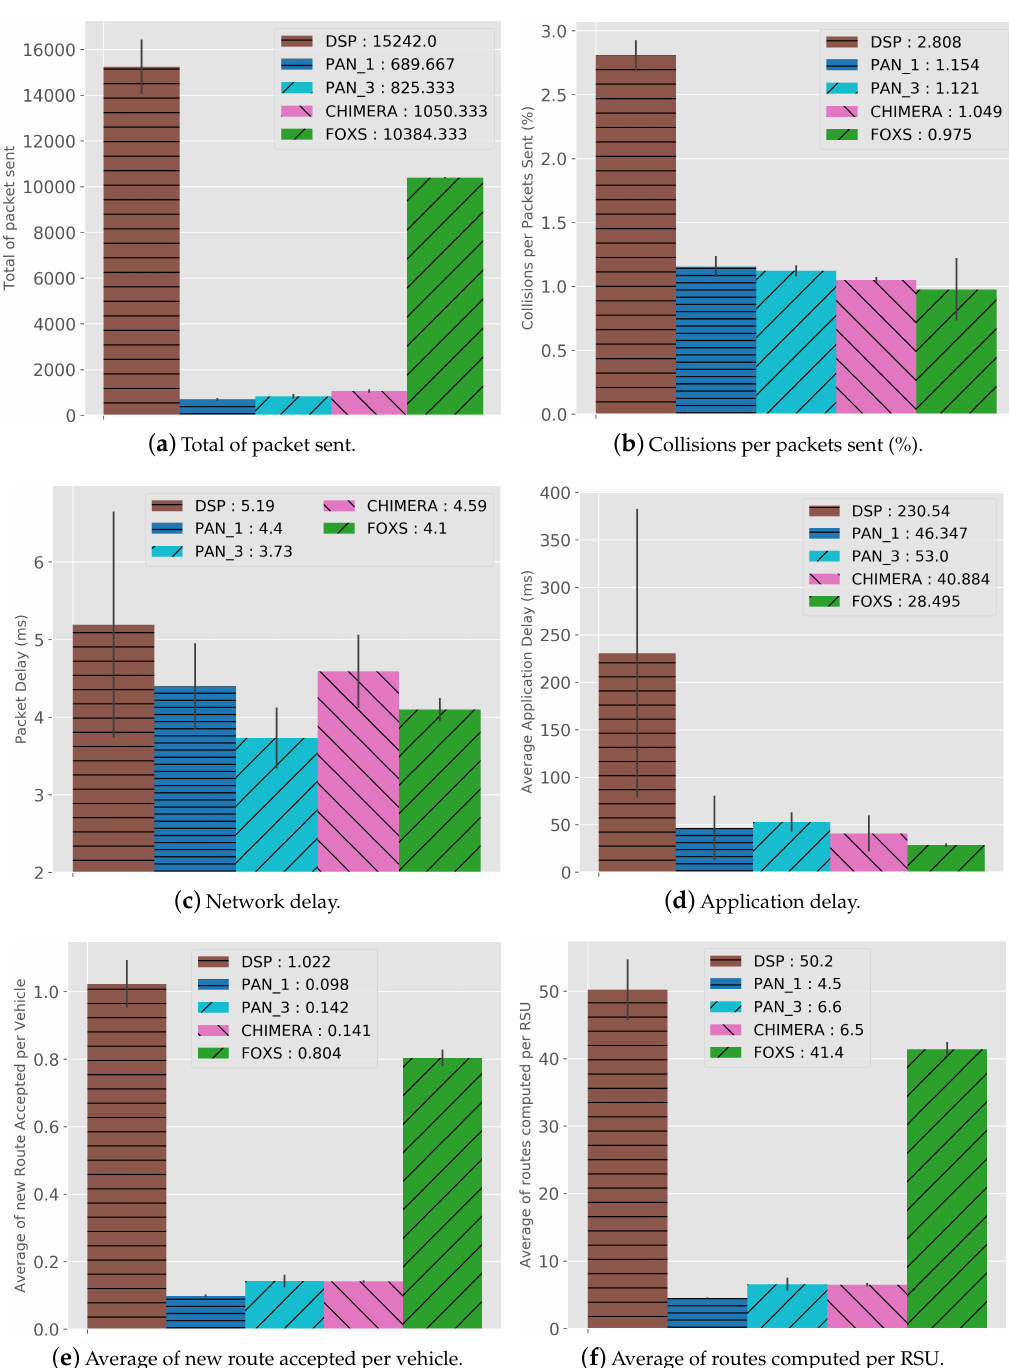
Figure 14. Network Cost Results—Ottawa